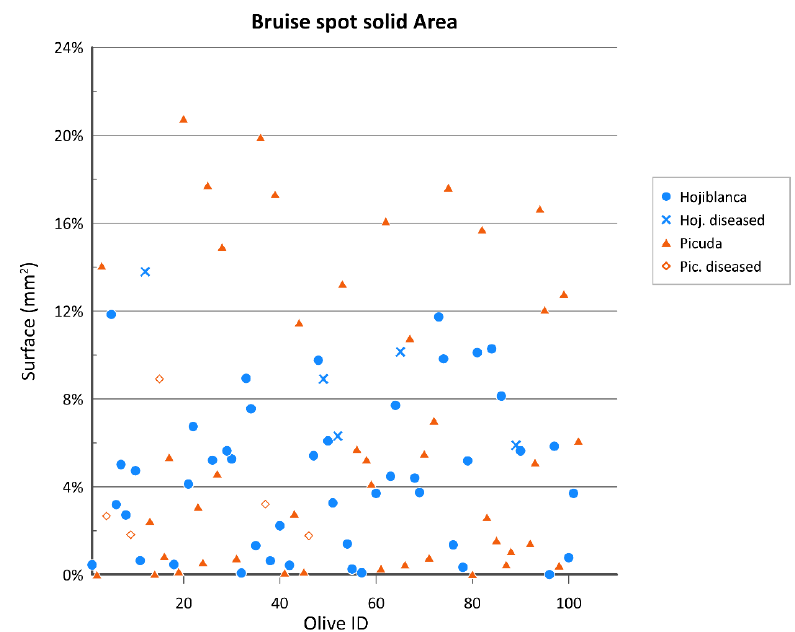
Figure 25. Bruise spot solid area plot.